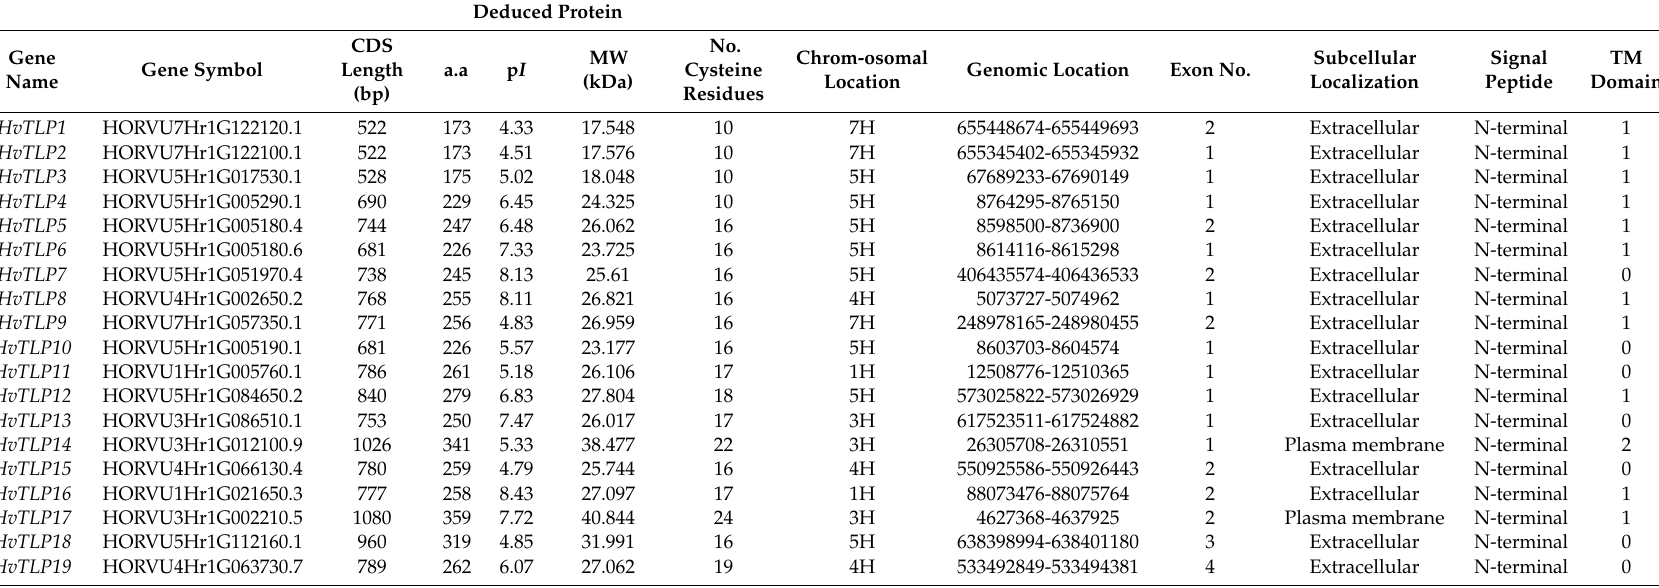
Table 1. Characteristics of newly identified barley TLP